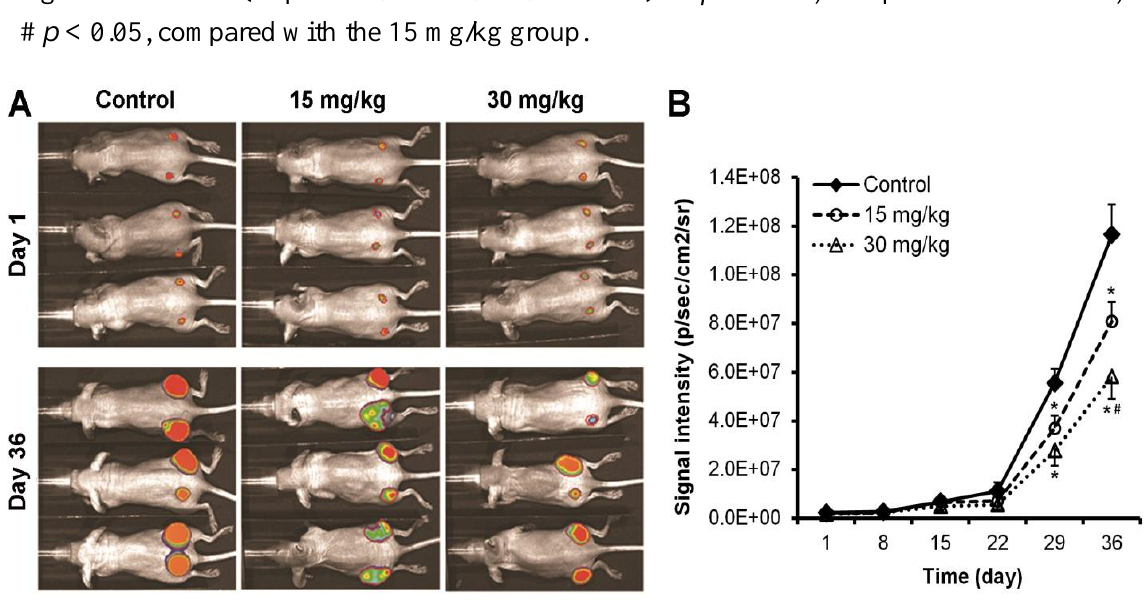
Figure 2. Oplopantriol A (OPT A) inhibits colon tumor growth in mice. ( A ) Human HCT-116 colorectal cancer cell xenografted tumor growth is monitored with Xenogen bioluminescence imaging assay on a weekly basis ( n = 6). Representative